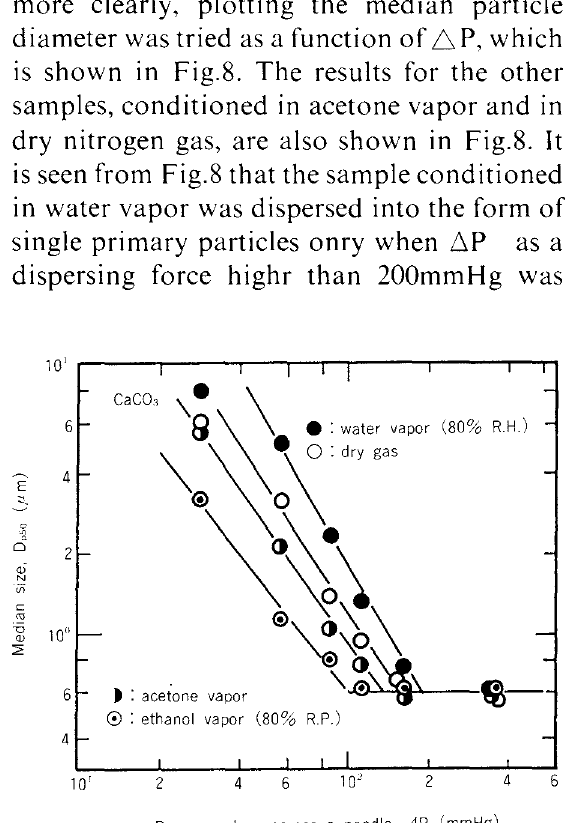
Fig.8 Change in mean size of the limestone Powder total gas pressure drop across a needle